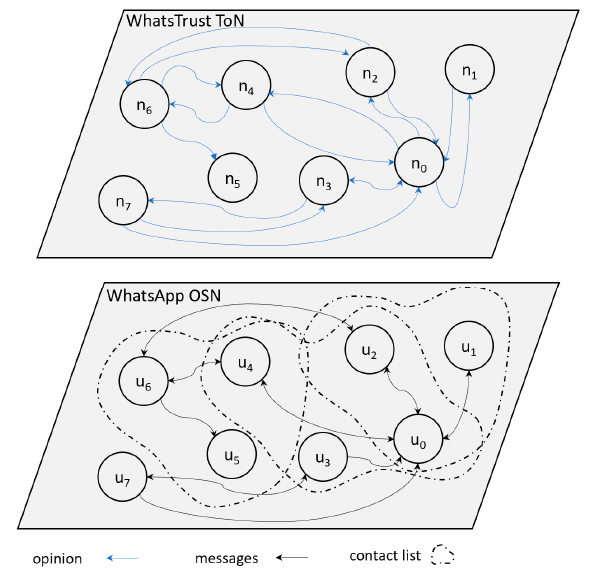
Figure 1. WhatsTrust trust overlay network (ToN).